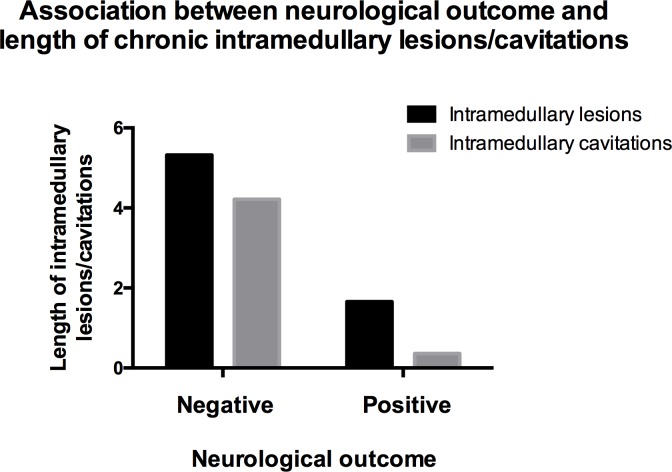
Association between length of chronic intramedullary lesions/cavitations and neurological outcome (P<0.0001).Dogs with negative neurological outcomes did not regain ambulation within 7 months after presentation in the hospital. Dogs with positive neurological outcomes regained ambulation within 7 months after presentation in the hospital.